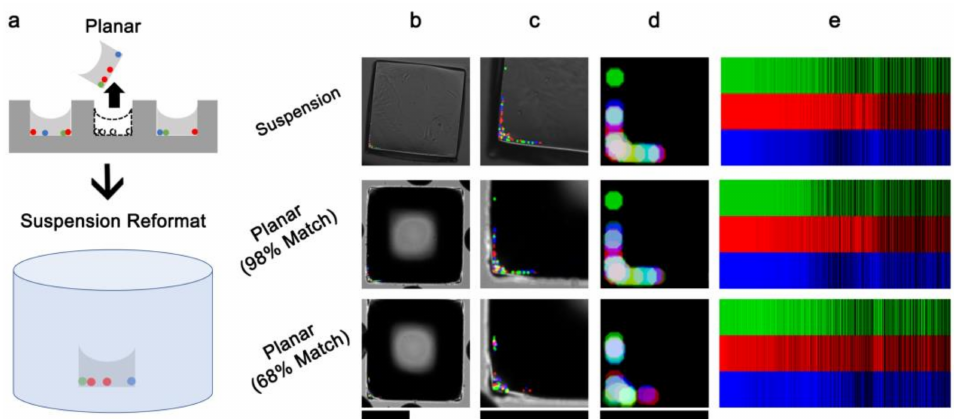
Figure 5. EM barcoding using embedded fluorescent microspheres. ( a ) Schematic of reformatting planar EMAs to suspension EMAs. ( b – e ) Representative barcoding results for an EM imaged in suspension and planar formats (top and middle rows), in contrast to a distinct non-matching EM (bottom row). ( b ) Composite widefield microscopy image of the EM element, scale bar: 250 µ m; ( c ) magnified view of the encoding microbeads, scale bar: 200 µ m; ( d ) registered and processed composite image, scale bar: 200 µ m; ( e ) tricolor barcodes (for clarity, only the first 1500 codes are shown). Microstructures were prepared using the rotational